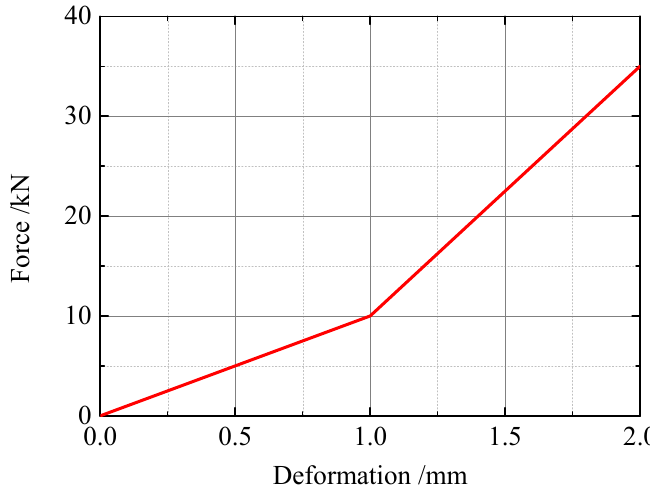
Figure 4. Turnout switching simulation model. Figure 3. Transverse stiffness of fastener system. Figure 3. Transverse stiffness of fastener system. Figure 3. Transverse stiffness of fastener system.